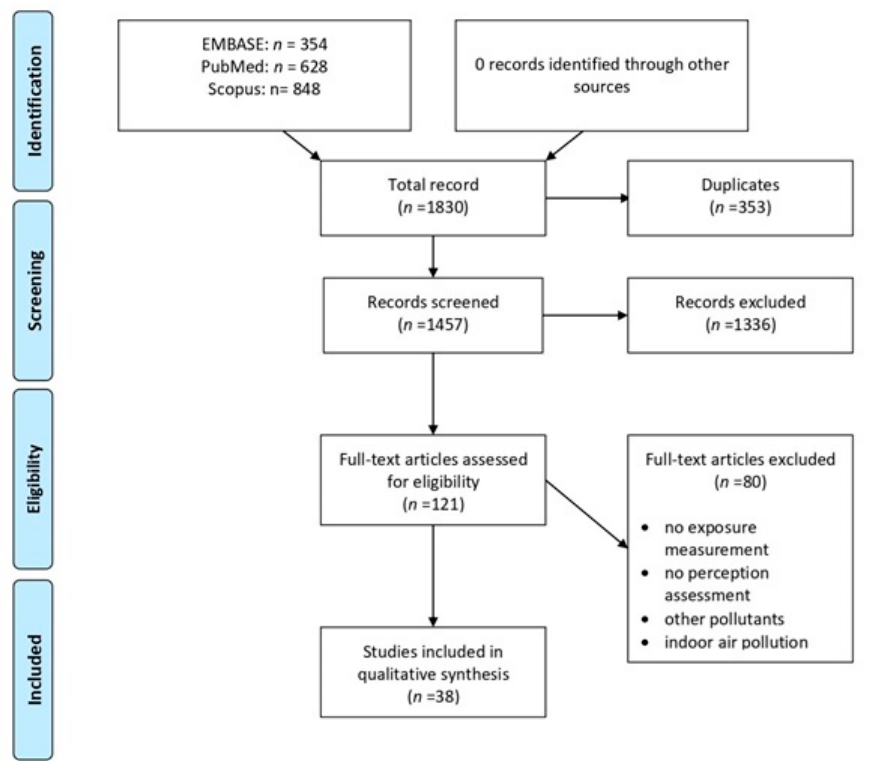
Figure 1. PRISMA flow diagram.